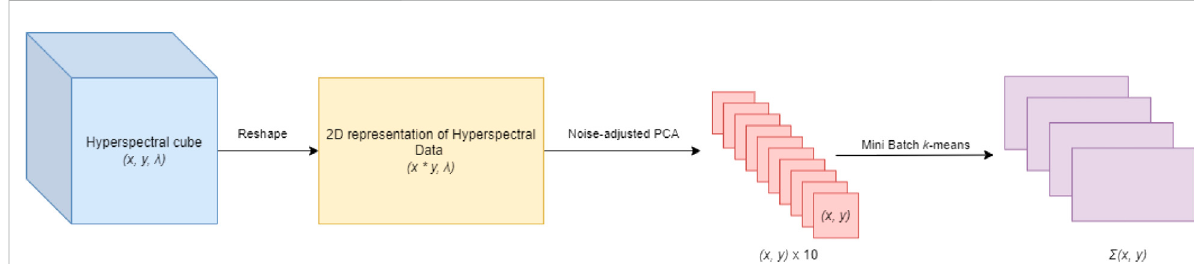
FIGURE 5 The data segmentation pipeline showing the fl ow of data during the initial segmentation.